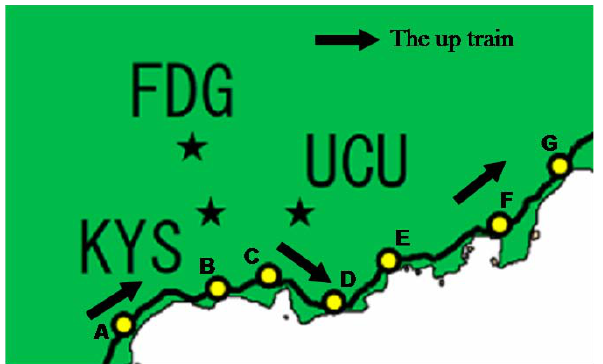
Fig. 15. The location of the stations and the traveling direction of the first train used in Figs. 14, 16, 17, 18 and